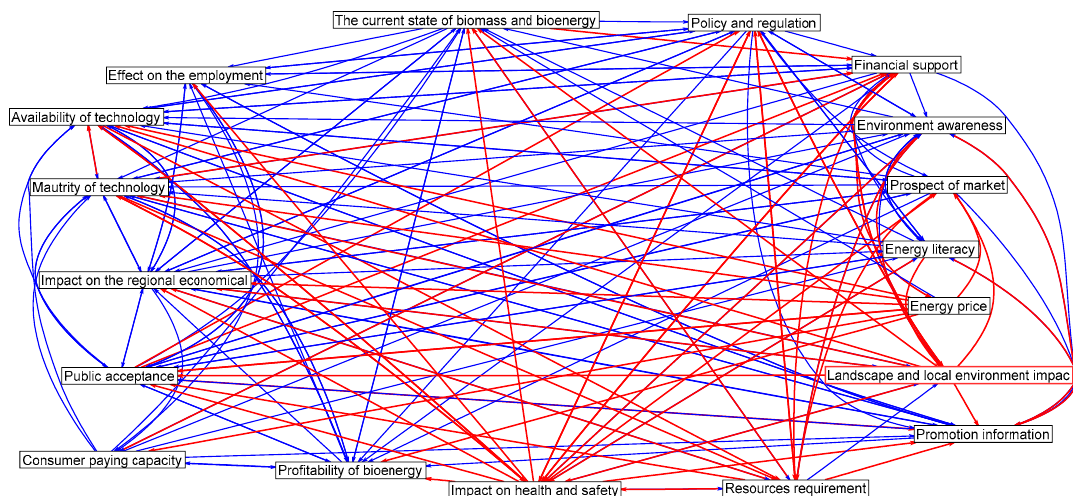
Figure 4. The collective fuzzy cognitive map.